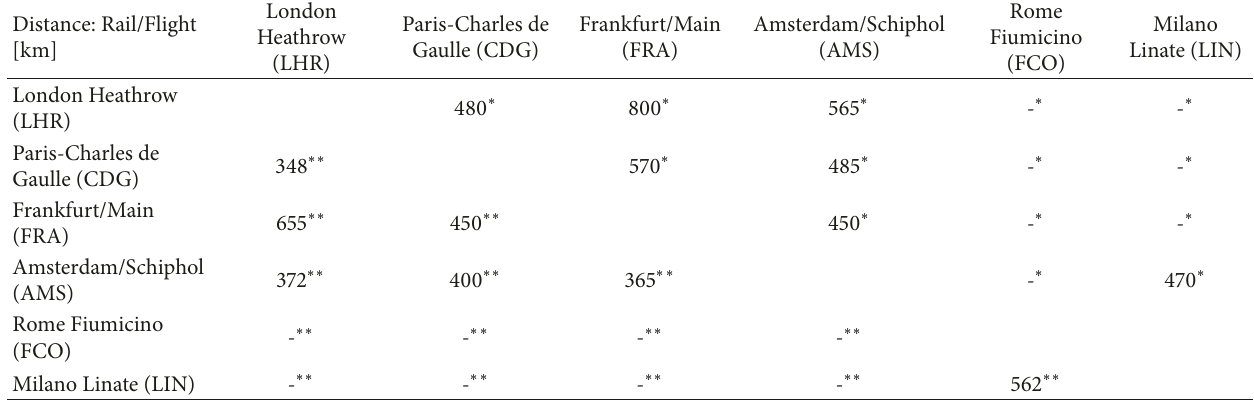
Table 2: Relative distances for railways ( ∗ ) and air flights ( ∗∗ ).